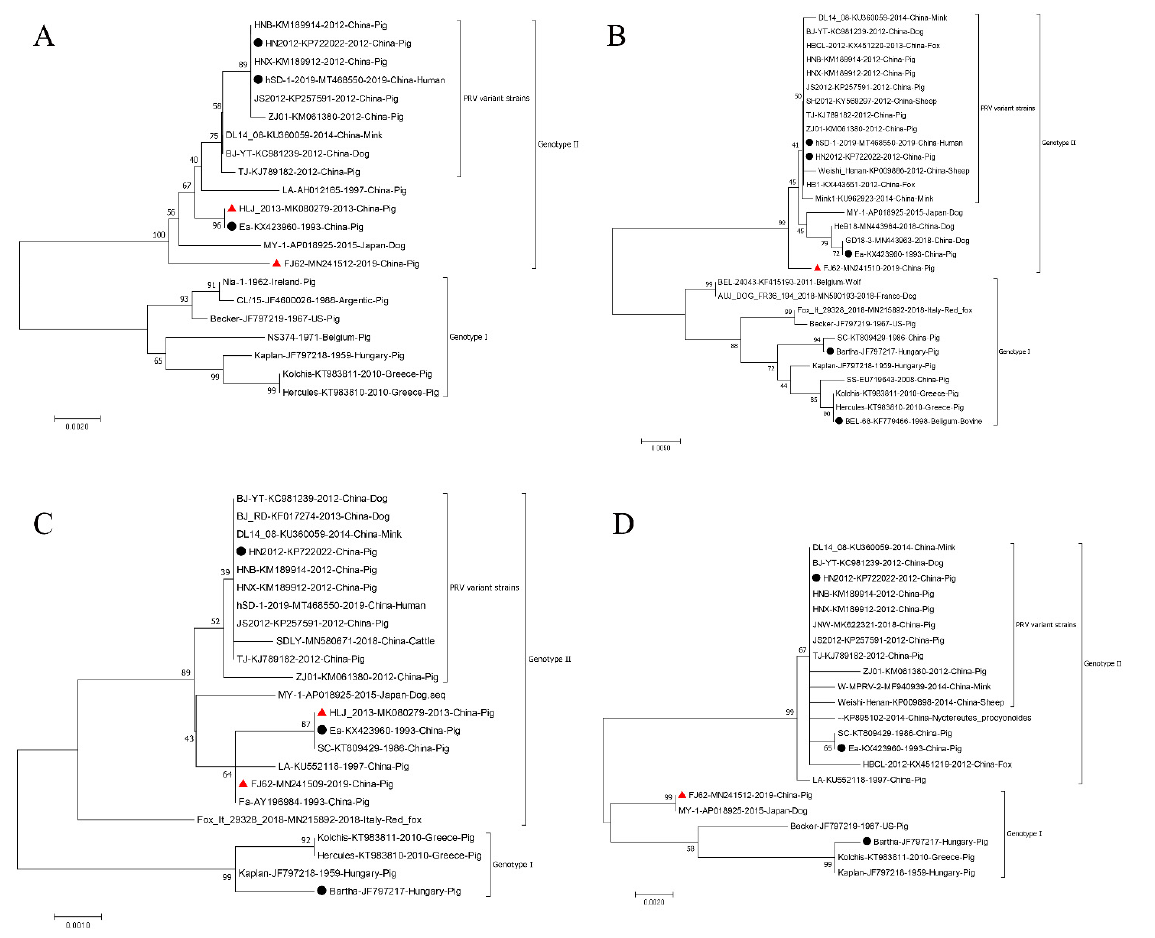
Figure 5. Phylogenetic trees based on the nucleotide sequences of the gE ( A ), gC ( B ), gD ( C ) and gB ( D ) genes of PRV strains from different hosts/regions using the neighbour-joining method with a bootstrap test of 1000 replicates using MEGA 7.0 software (www.megasoftware.net; Access date: 15 th April 2022). The hosts, countries, years, names and GenBank accession numbers of the reference strains employed in this phylogenetic tree are labeled. Black circles and red triangles represent vaccine strains and recombinant strains, respectively.